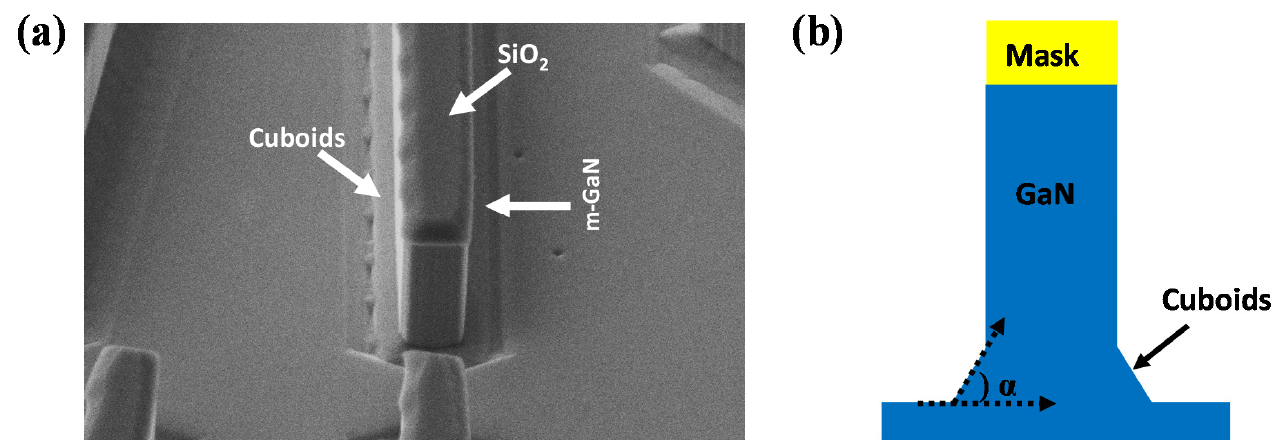
Figure 4. Groove formation due to the GaN etching; ( a ) This work; ( b ) description of cuboids formation.